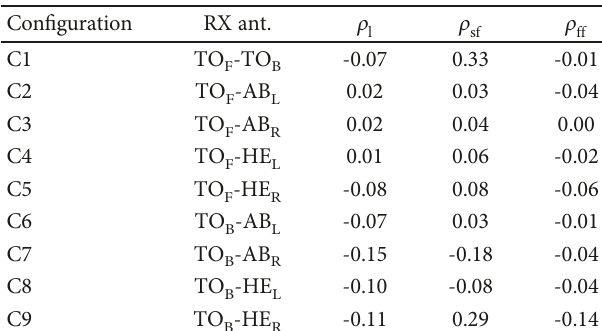
Table 5: Correlation coe ffi cient between system loss values ( ρ slow fading component ( ρ sf ), and fast fading component ( ρ ff ), calculated based on the signals received by two wearable antennas.